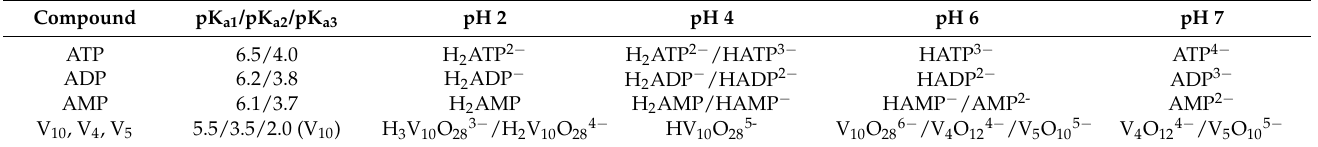
Table 4. Protonation states of each compound at the pH values used for reactions.